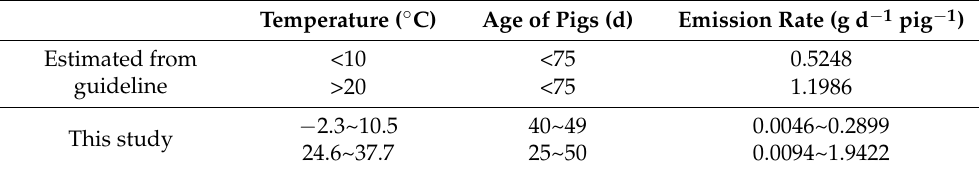
Table 2. Emission factors from this study and guideline for inventory.